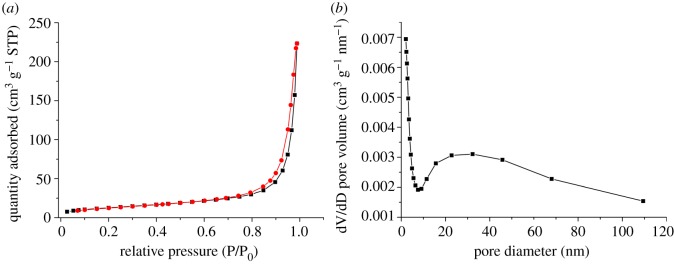
N2 adsorption–desorption isotherm (a) and the corresponding BJH pore size distribution (b) of the PEG@MoS2 composite.